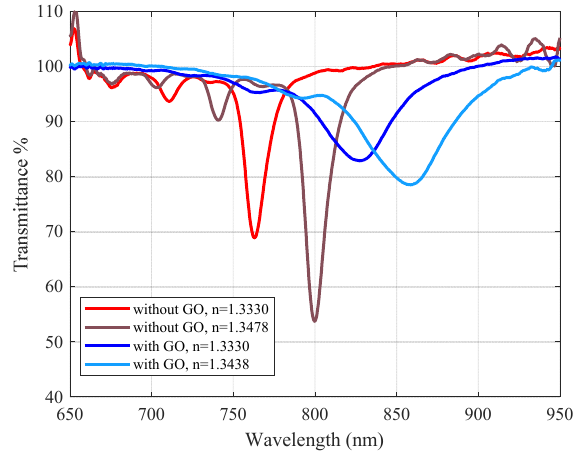
Figure 8. Experimental spectral transmittance against external medium index variations of a DLUWT with (blue lines) and without (red lines) a GO deposition.